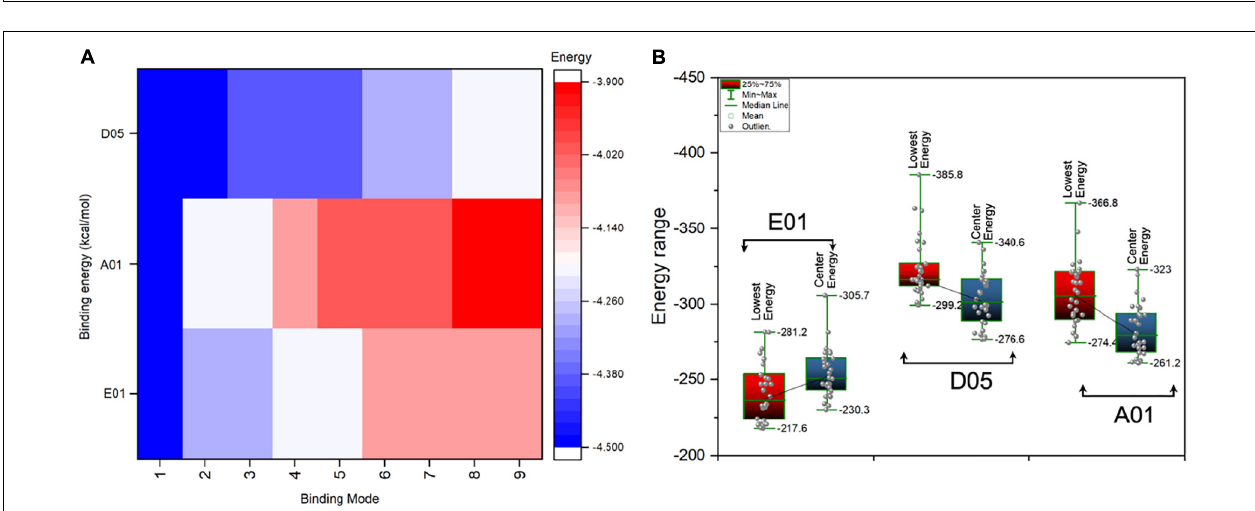
FIGURE 4 | (A–C) Amino acid substitution map for heavy and light chain sequences compared to ImMunoGeneTics information system human (IMGT) germline genes. The amino acid substitutions are depicted for different clones, i.e., E01, A01, and D05, respectively. The red bar represents the substitution of amino acid.